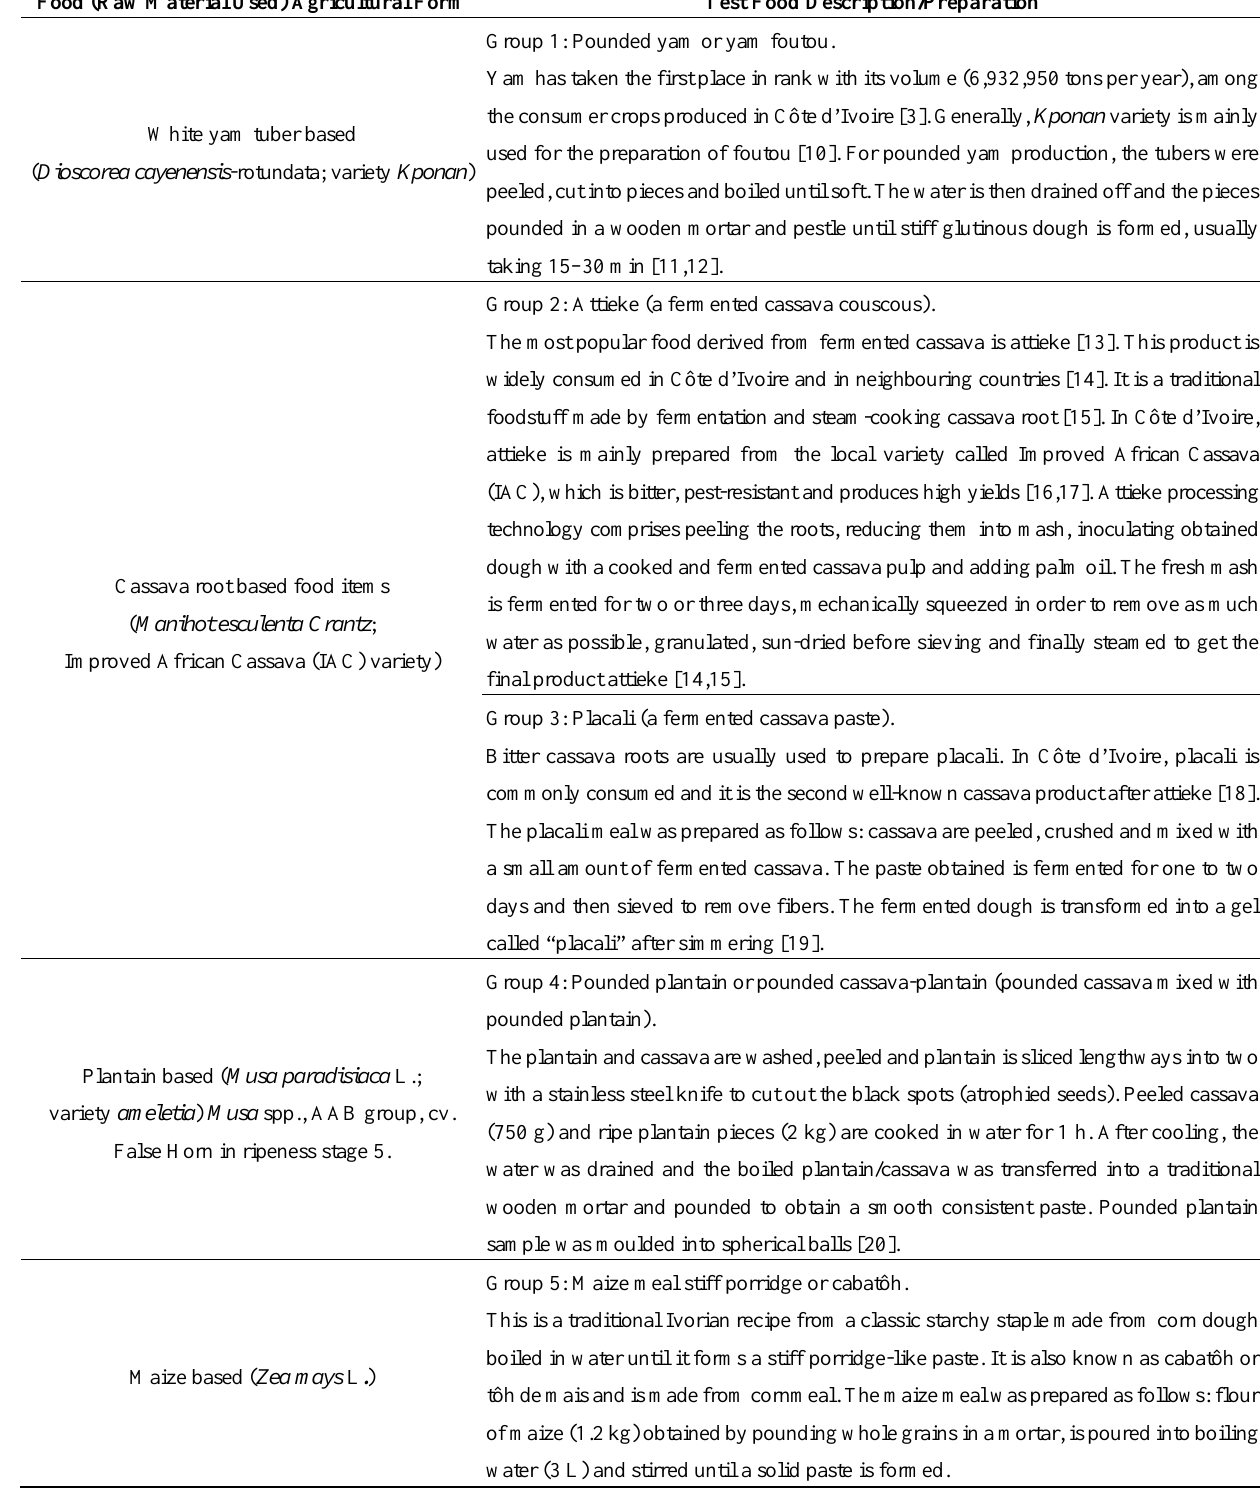
Table 1. Processing and preparation of